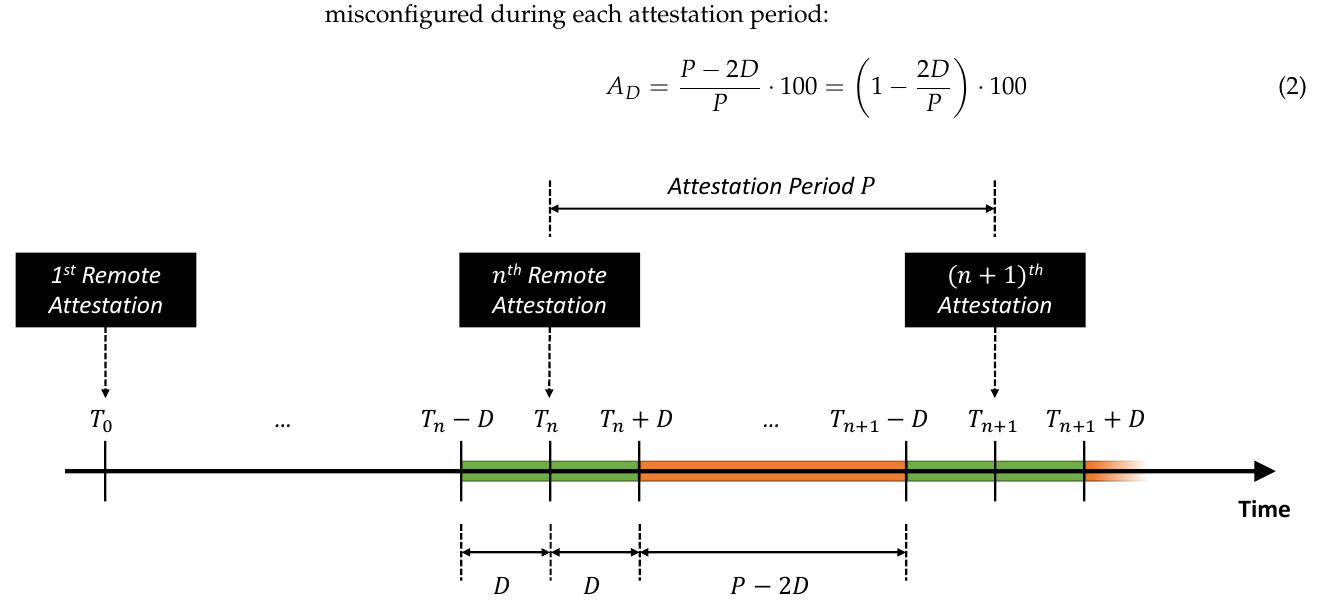
Figure 10. Illustration of the advanced attack scenario.